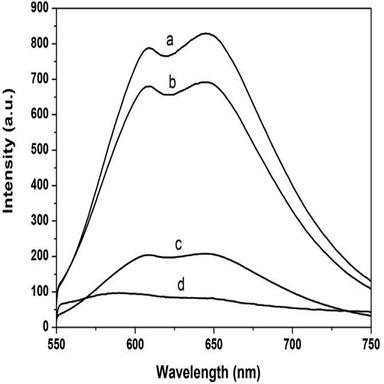
Fluorescence spectrum of P3HT-MWCNT prepared by click chemistry (solvent: chloroform): (a) P3HT; (b) physical blends of P3HT and 50 wt% MWCNT; (c) physical blends of P3HT and 80 wt% MWCNT; (d) P3HT-MWCNT.